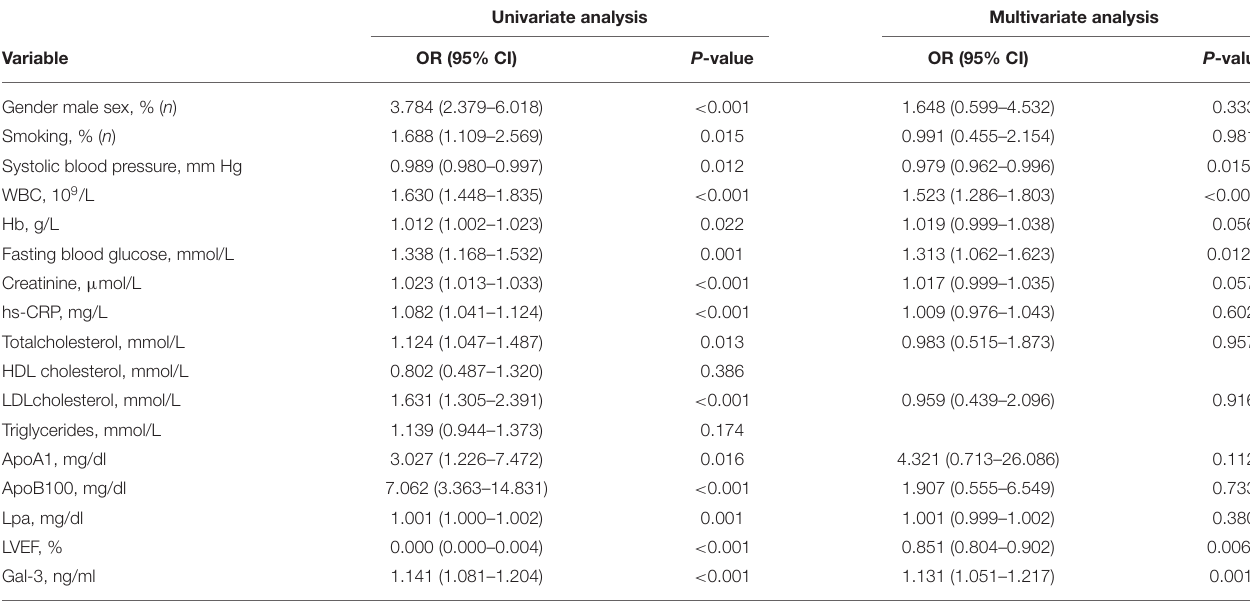
TABLE 4 | Logistic regression analysis for risk factors attributing to ACS presence in the study.